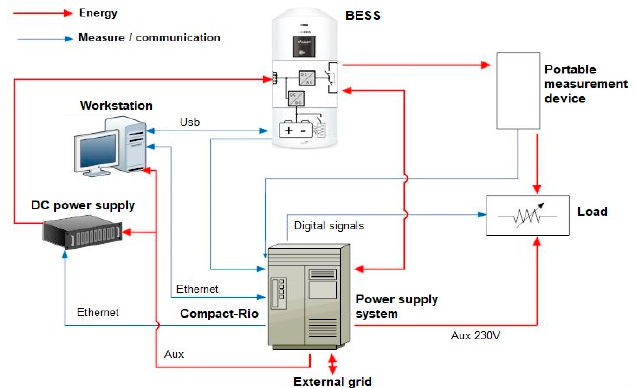
Figure 11. Test bench layout.